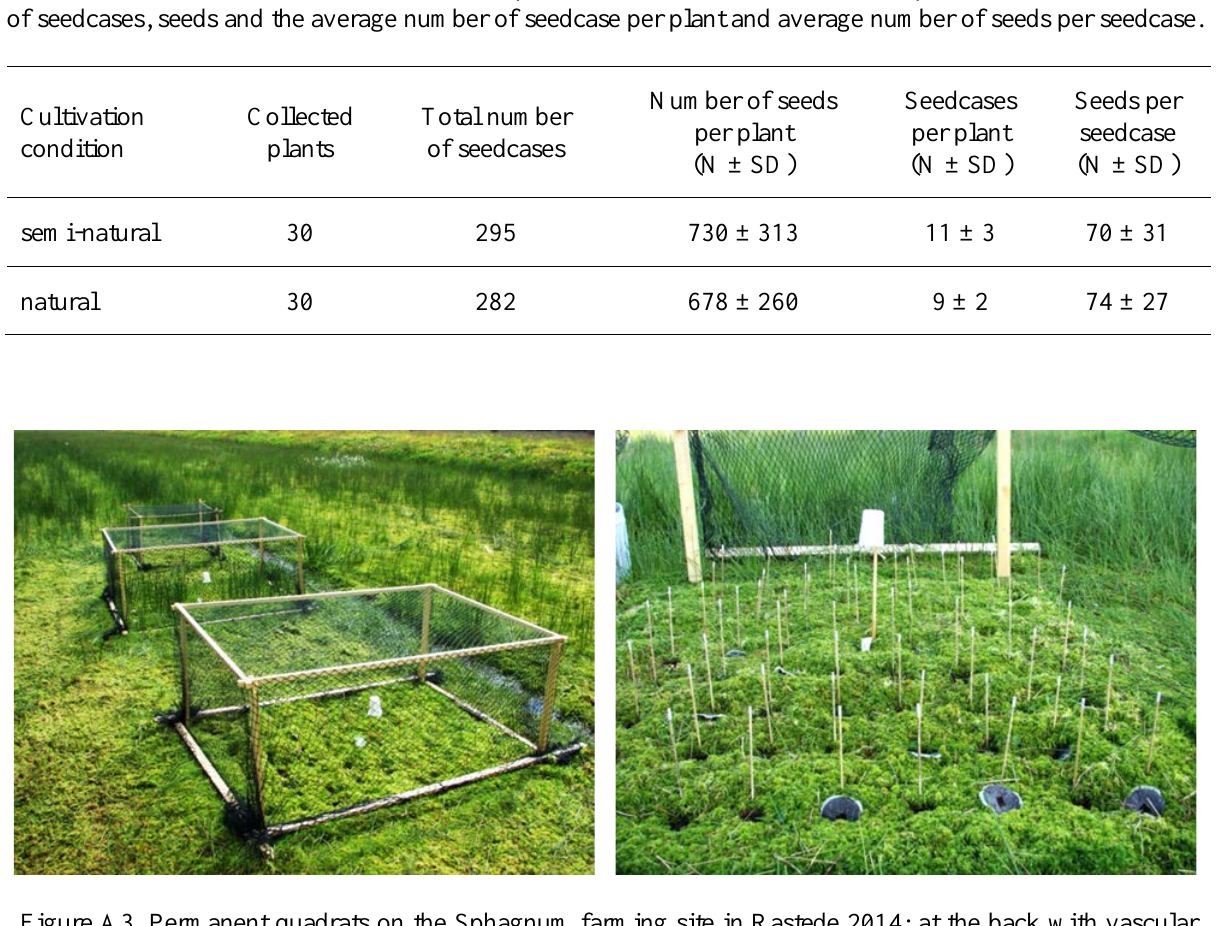
Table A2. Collected seeds of Drosera rotundifolia for the experiment in semi-natural (Sphagnum farm) and natural (Fekete-tó) cultivation conditions in September 2013 – number of collected plants with its total number of seedcases, seeds and the average number of seedcase per plant and average number of seeds per seedcase.